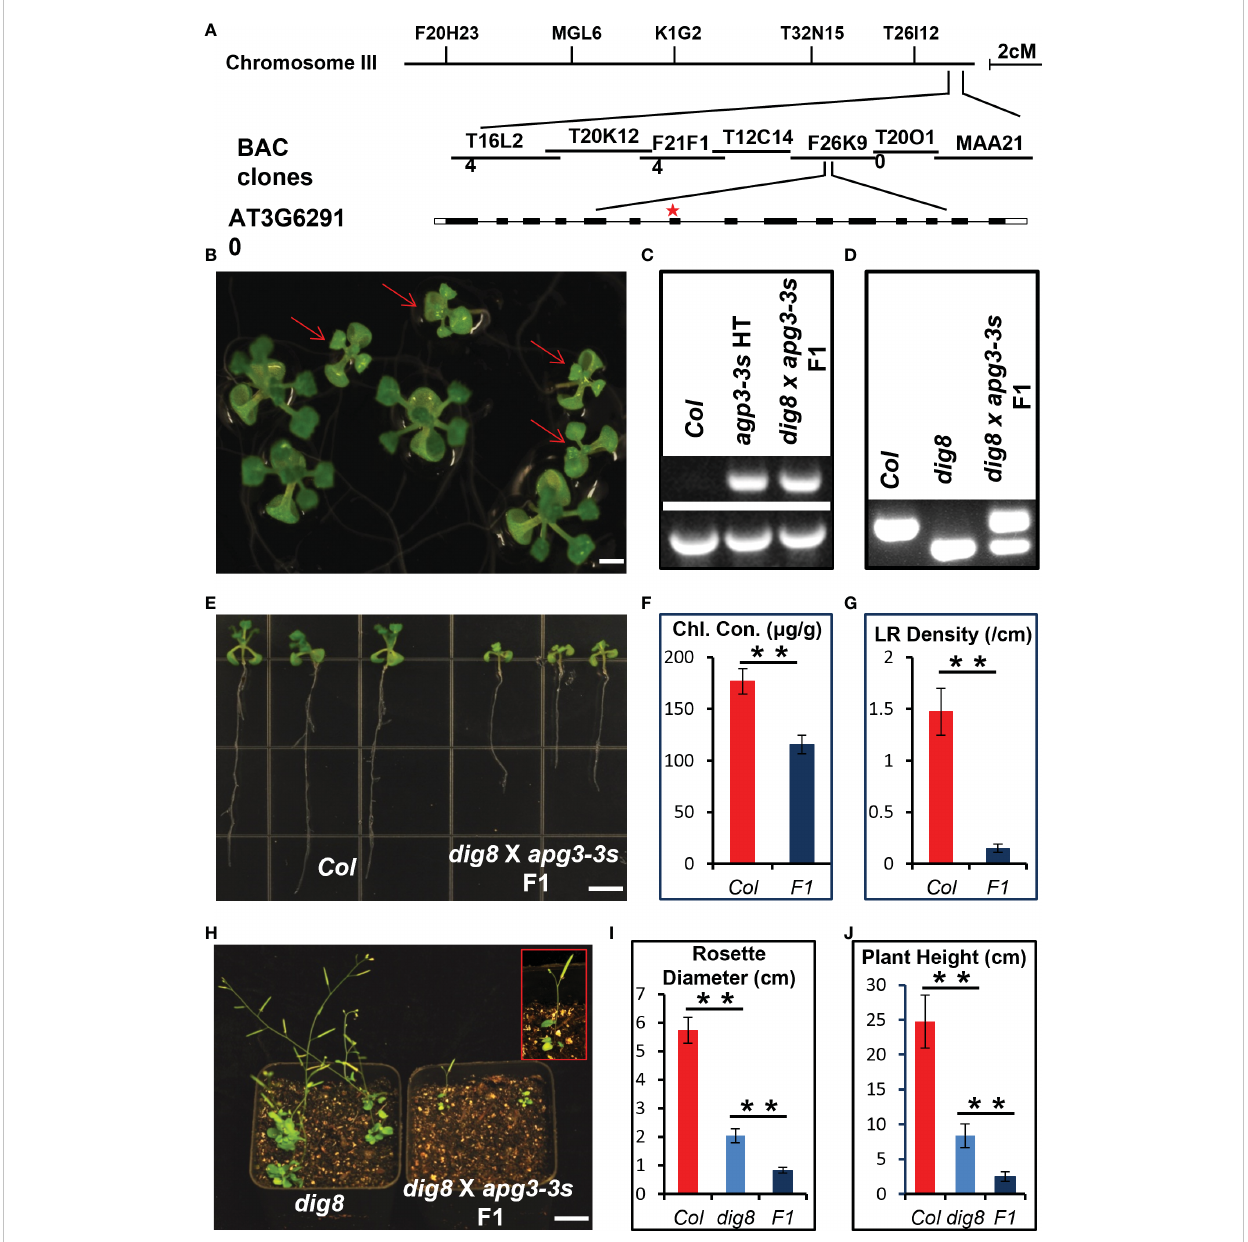
FIGURE 3 Mapping and allelic veri fi cation of DIG8 . (A) , Map-based cloning of the DIG8 locus. The dig8 mutant was crossed with the Ler ecotype and the F 2 population was used for mapping. DIG8 was localized on Chromosome 3. Schematic structure of the DIG8 gene (AT3G62910); black boxes, exons; white boxes, UTRs; lines, introns; star, dig8 mutation site. (B) , Allelic veri fi cation of DIG8 gene. Then dig8 mutant was crossed with an apg3-3s heterozygote. F 1 seedlings on MS medium showed segregation ratio of 1 normal: 1 defective (arrows) seedling as expected for allelic mutations. Scale bars, 0.2 cm. (C) , PCR veri fi cation of T-DNA insertion in the apg3-3s mutant allele. Lower bands were generated by PCR using primers LP and RP; upper bands by PCR using primers LB and RP. (D) , dCAPS veri fi cation of dig8 mutant site. The BglII site was designed in reverse primer for dig8 mutant site. PCR products were digested with BglII to verify the point mutation in dig8 mutant. (E) , Lateral root and pale green phenotypes of dig8 x apg3-3s F 1 seedlings compared to Col. (F) , Total chlorophyll contents in Col and dig8 x apg3-3s F 1 seedlings. Error bars represent SD from three independent replicates. (G) , Lateral root (LR) densities of Col and F 1 mutant seedlings. Error bars represent SD (n=20). Scale bars, 0.5 cm. (H) , Comparison of dig8 x apg3-3s F 1 with dig8 mutant. Enlarged view of a dig8 x apg3-3s F 1 plant in red rectangle showing 3 rosette leaves and 1 silique at the reproductive stage. Scale bars, 1 cm. I and J, Comparisons of rosette width (I) and plant height (J) of Col, dig8 and dig8 x apg3-3s F 1 seedlings. Error bars represent SD ( n =20). Asterisks indicate a signi fi cant difference between the indicated samples ( t -test, **P <